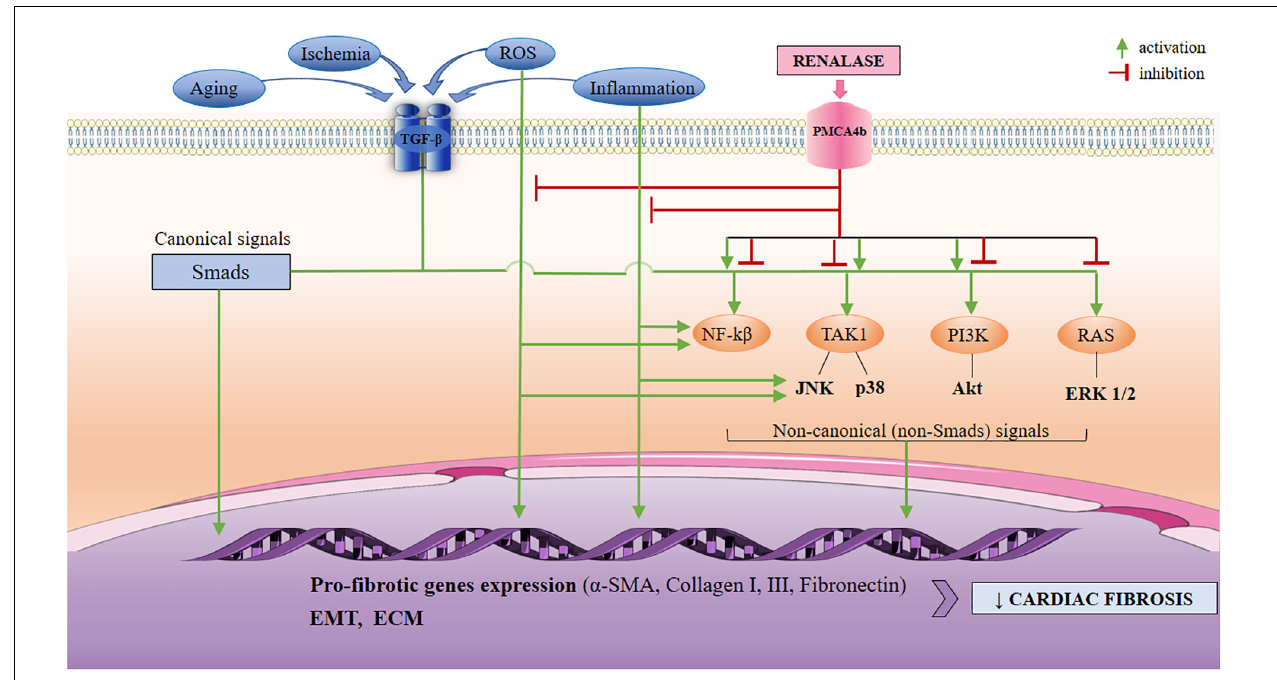
FIGURE 1 | A schematic view of the TGF- β -mediated activation of non-Smad (non-canonical) pathways, with respect to anticipated signaling arms that may be targeted by renalase. The non-canonical network which includes the MAPKs (ERK 1/2, JNK, p38), PI3K/Akt, and NF- κβ may all be modulated by renalase, at different levels: renalase inhibits or activates phosphorylation and the activation of p38, and PI3K/Akt pathways; it also downregulates phosphorylation of ERK 1/2, and JNK, and is up-regulated by NF- κβ . The mediation of the TGF- β non-canonical signaling by renalase is likely context-dependent to regulating EMT, and pro-fibrotic gene expression ( α ’ -SMA, collagens I, III, fibronectin), and results in increased ECM, and diminished MMP-1 expression. Based upon current data, renalase does not mediate the canonical (Smad2/3) network. TGF- β , transforming growth factor- β ; PMCA4b, plasma membrane calcium-ATPase 4b; MAPKs, mitogen-activated kinases; ERK 1/2, extracellular regulated protein kinases 1/2; JNK, c-Jun N-terminal kinases; PI3K/Akt, phosphatidylinositol 3-kinase/protein kinase B; NF- κβ , nuclear factor κβ ; EMT, epithelial to mesenchymal transition; α -SMA, α -smooth muscle actin; ECM, extracellular